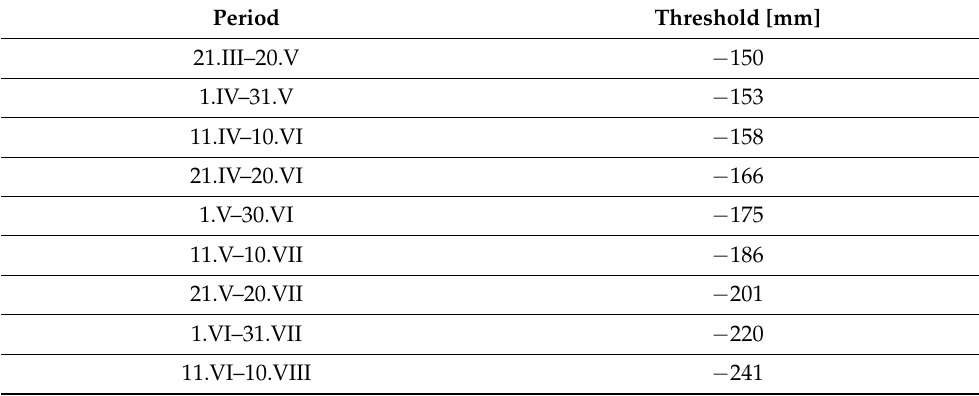
Table 5. Drought threshold in a two-month period for winter wheat on soils in the second drought susceptibility